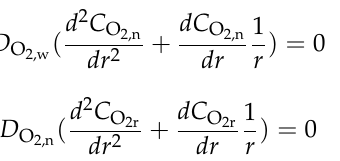
Figure 3. Schematic of oxygen transport in ordered catalyst layer. Oxygen concentration gradients of OCCL are caused by the resistance of oxygen as it passes through the water and polymers. The oxygen concentration at ionomer boundaries C O can be calculated by Equation (21). The oxygen content at the triple-phase interface 2,n C O could be determined by Equation 2r